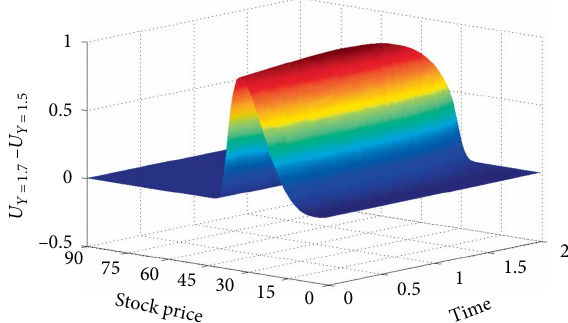
Figure 11: with 𝑈 𝑌=1.7 − 𝑈 𝑌=1.5 𝑟 = 0.05, 𝛾 = 0.08, 𝐶 = 0.03, 𝐺 = 1.2, . 𝑀 = 3, 𝑇 = 2, 𝐾 = 50